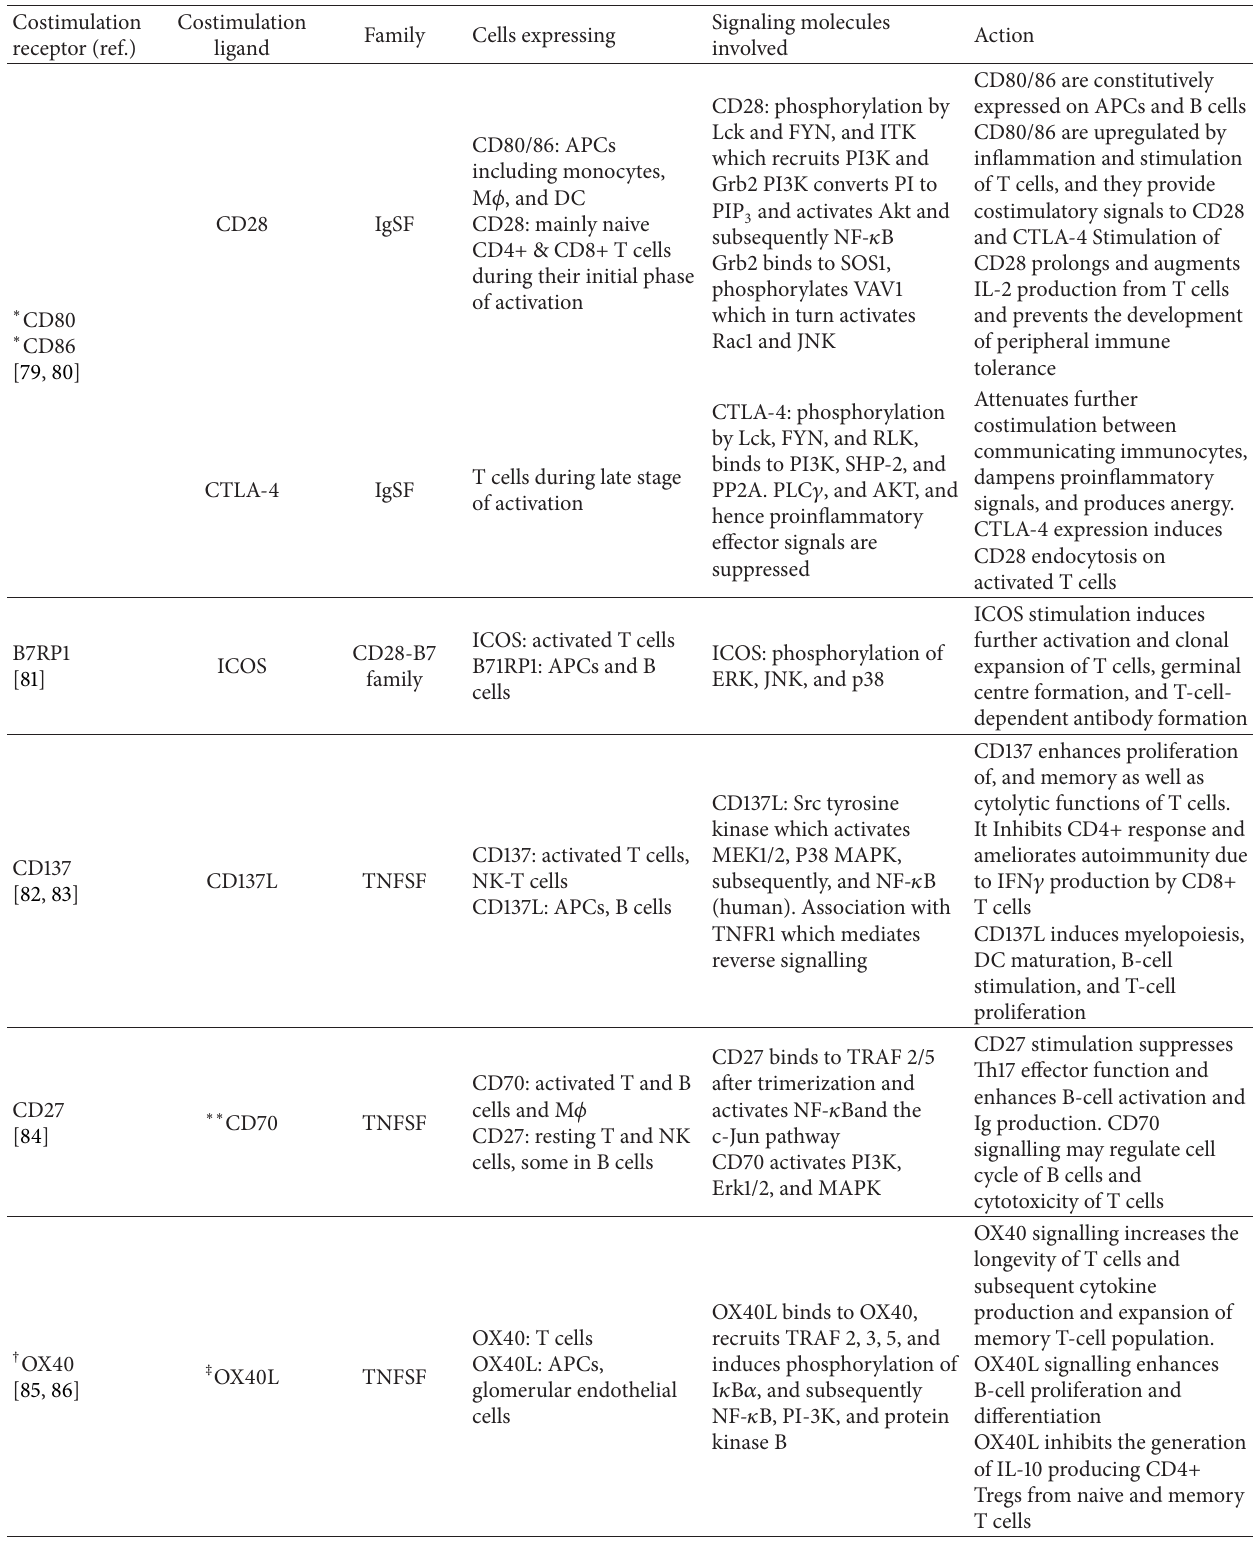
Table 1: Summary of the signalling mechanisms and physiological actions of major co-stimulatory molecules in systemic lupus